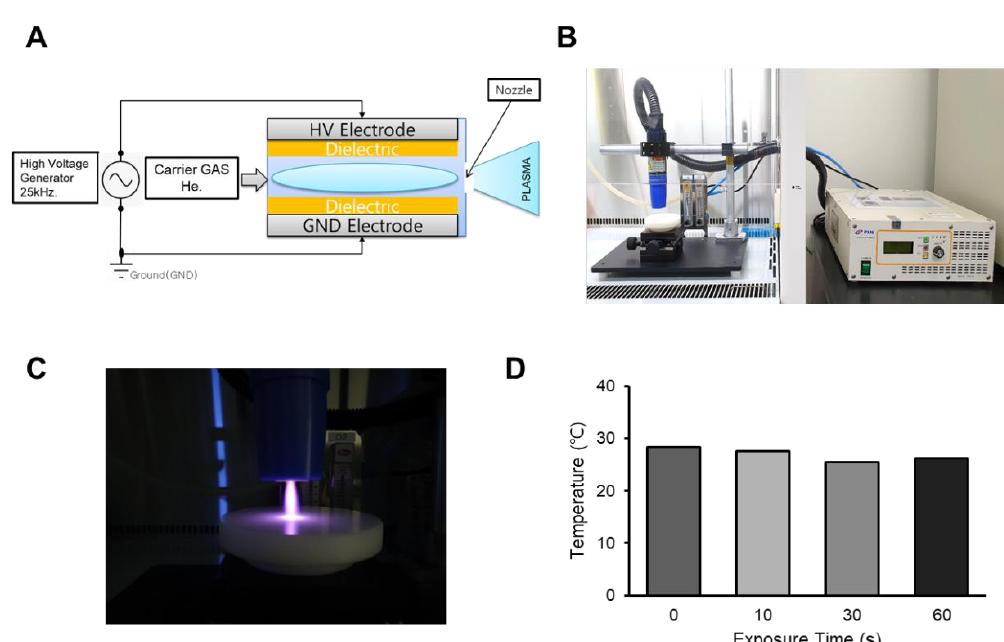
Figure 1. Cold atmospheric plasma (CAP) generated by dielectric-barrier discharge (DBD). ( A ) Schematic diagram of the DBD plasma device. ( B ) A photograph showing the plasma torch and its associated power supply used in this study. The plasma jet was placed on the clean bench, and all the experiments were conducted in the hood. ( C ) Representative image of cold atmospheric plasma jet using helium gas. The power was adjusted to 300 W, and the flow rate of helium (He) gas was 20 L per minute. ( D ) After CAP application to the medium, the temperature was measured at the indicated time.